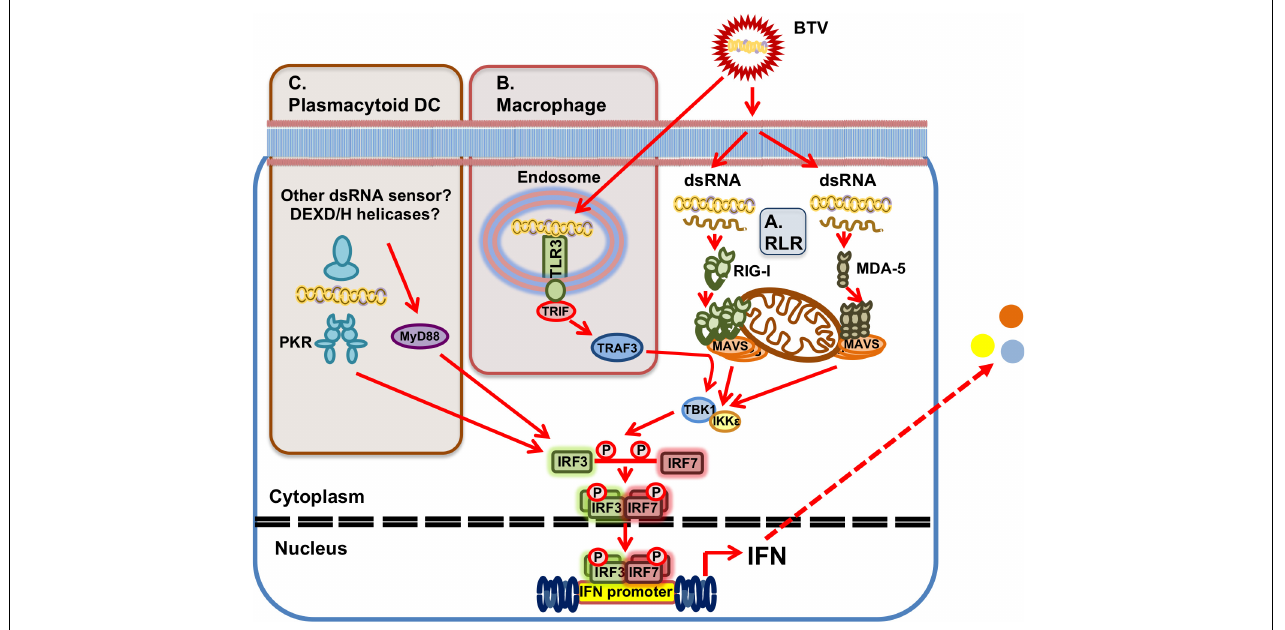
FIGURE 3 | BTV sensing by PRRs. (A) Ubiquitously expressed RLRs can detect BTV dsRNA presence in the cytoplasm. RIG-I and MDA-5 are involved in BTV recognition and this triggers a signaling cascade that results in IFN induction through activation of the MAVS/TBK1 pathway. (B) In macrophages, TLR3 in endosomes can also recognize BTV dsRNA resulting in IFN induction and the generation of an antiviral state. (C) In plasmacytoid DC, which do not express TLR3, PKR is involved in dsRNA recognition in the cytoplasm and IFN induction. IFN induction in these cells is also dependent on the adaptor MyD88 for IFN induction, but recognition is independent of TLR7. Whether other dsRNA sensors, such as DEXD/H-box helicases are involved upstream of MyD88 for dsRNA sensing in pDCs has yet to be